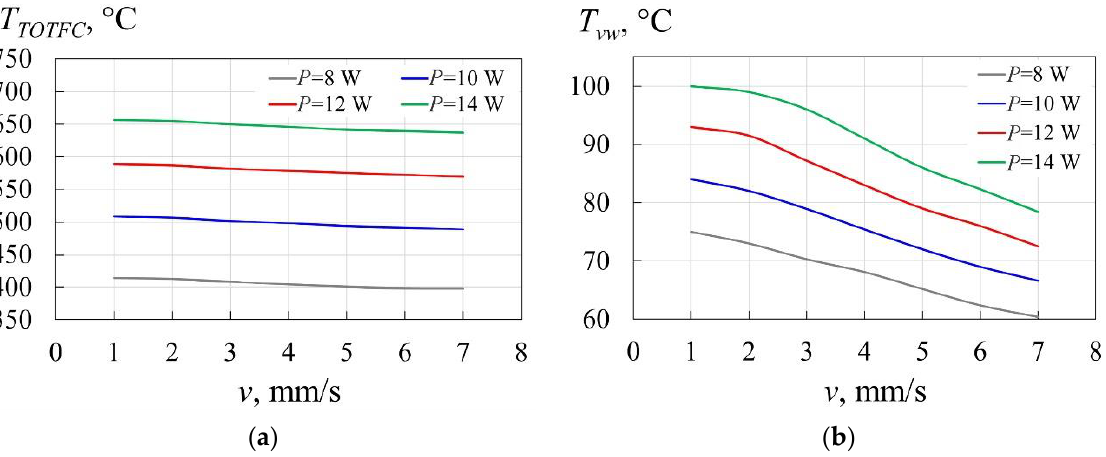
Figure 2. The dependences of T TOTFC ( a ) and T vw ( b ) on the traction speed ( v ), at a varied average laser radiation power ( P ) (the wavelength of laser radiation is 980 nm, the inner vein diameter is 5 mm).